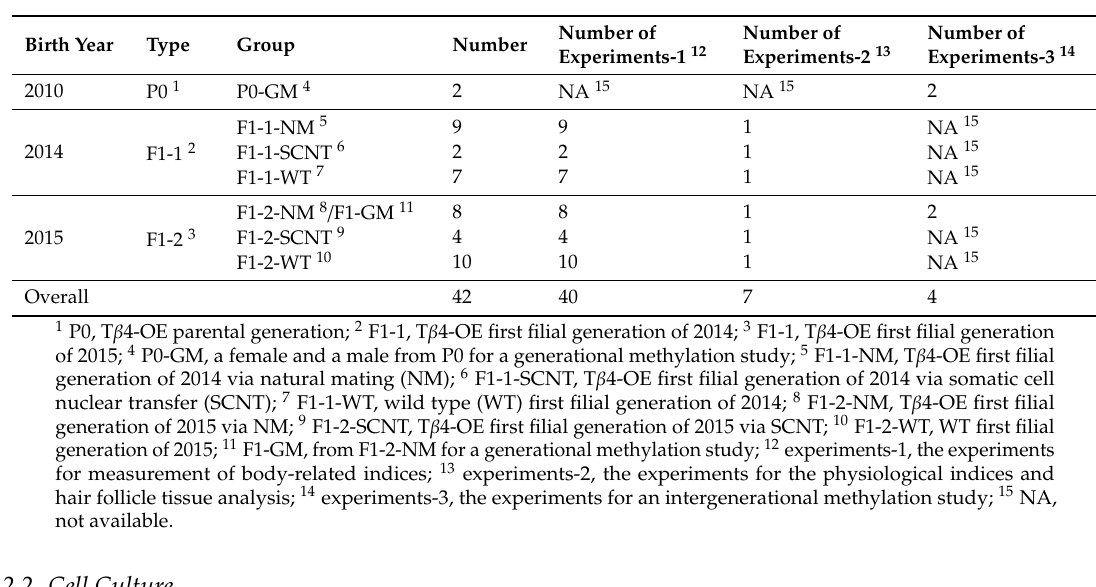
Table 1. Goats used for this